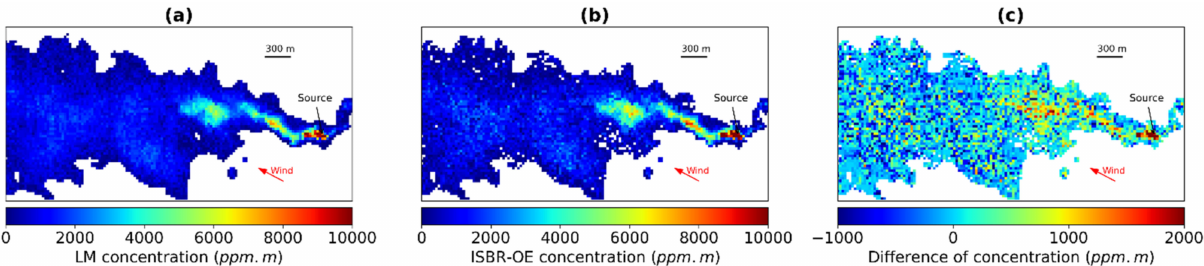
Figure 4. ( a ) Concentration map obtained by LM for the 2020/07/21 PRISMA image. ( b ) Concentration map obtained by ISBR-OEM for the same image. ( c ) Difference between both concentrations ( b ) − ( a )). The black arrows indicate the emission point and the red arrows indicate the wind direction. The color bar is cut off at 10,000 ppm · m for ( a ) and ( b ) whose maximum is 15,000 and 20,000 ppm · m, respectively. For ( c ), the color bar is cut off to a maximum difference at 2000 ppm ·